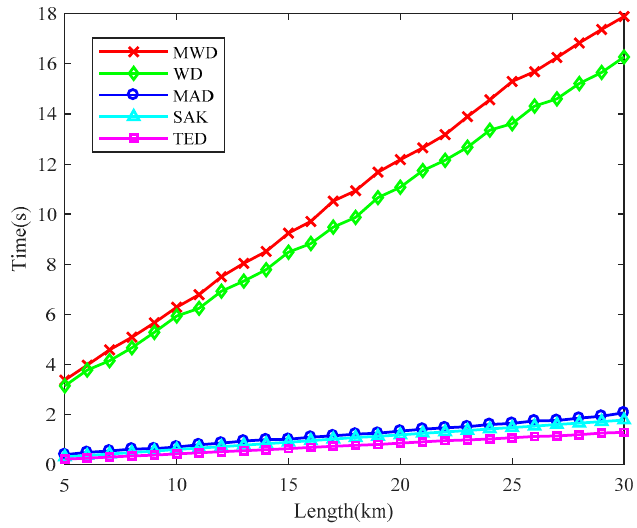
Figure 9. The time consumption of various locating methods under different fiber length.